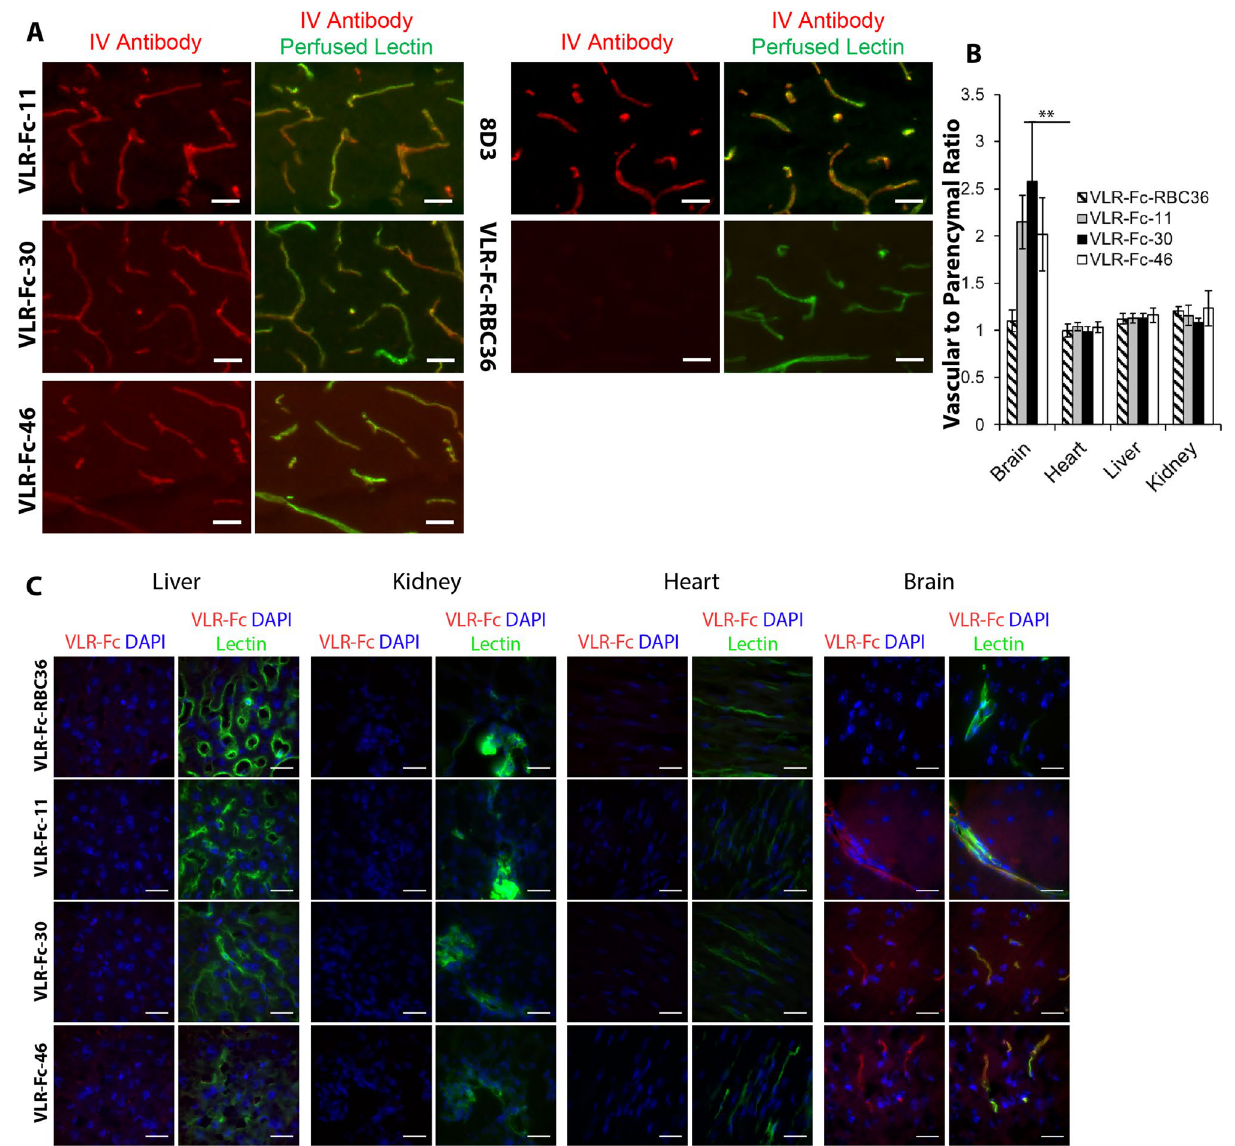
Figure 7. Vascular targeting and trafficking of VLR-Fcs after IV injection. Mice were administered 10 mg/kg of the indicated antibody construct (red). After 1 h of circulation time, mice were perfused with saline containing fluorescently labeled lectin (green) to remove unbound VLR-Fc and label the vascular lumen. ( A ) Low magnification fluorescence microscopy images from brain cortex. anti-TfR 8D3 antibody was used as a positive control for BBB targeting and VLR-Fc-RBC36 as an isotype control. Scale bars = 25 μm. ( B ) Ratio of vascular to parenchymal VLR signal, mean ± standard deviation, p < 0.01 = **determined with one-way ANOVA paired with Tukey’s post-hoc analysis. At least 5 different regions were imaged for each organ. ( C ) Representative images of vascular beds within the liver, kidney, heart, and brain. Scale bars = 25 -30 and -46 could be found in puncta at the abluminal membrane separated from the luminal lectin stain and co-localizing with the basement membrane (Fig. 8A). Similar results were observed with the 8D3, anti-TfR IgG control. These results were suggestive of VLR-Fc trafficking within the MBECs. To further confirm the MBEC trafficking capability of VLR-Fc-11, -30 and -46, immunogold electron microscopy was used to examine the ultrastructural localization of IV injected VLR-Fc at the brain microvasculature. VLR-Fc-11, -30 and -46 were all found localized to the luminal surface, in invaginating endocytic pits, within the cytoplasm of MBECs and at the abluminal membrane (Fig. 8B). By contrast, the isotype control VLR-Fc-RBC36 was not observed associated with the brain vasculature. Combined with the confocal microscopy analyses, these data indicate that VLR-Fc-11, -30 and -46 bind to the brain microvasculature and traffic across MBECs after systemic administration. Although the aforementioned data demonstrate that each of the 3 VLR-Fcs are capable of trafficking across the MBECs, the unequivocal ultrastructural detection of parenchymal VLR-Fc upon full transcytosis into brain is challenging. An antibody undergoes substantial dilution upon exiting the vesicular trafficking network of MBECs